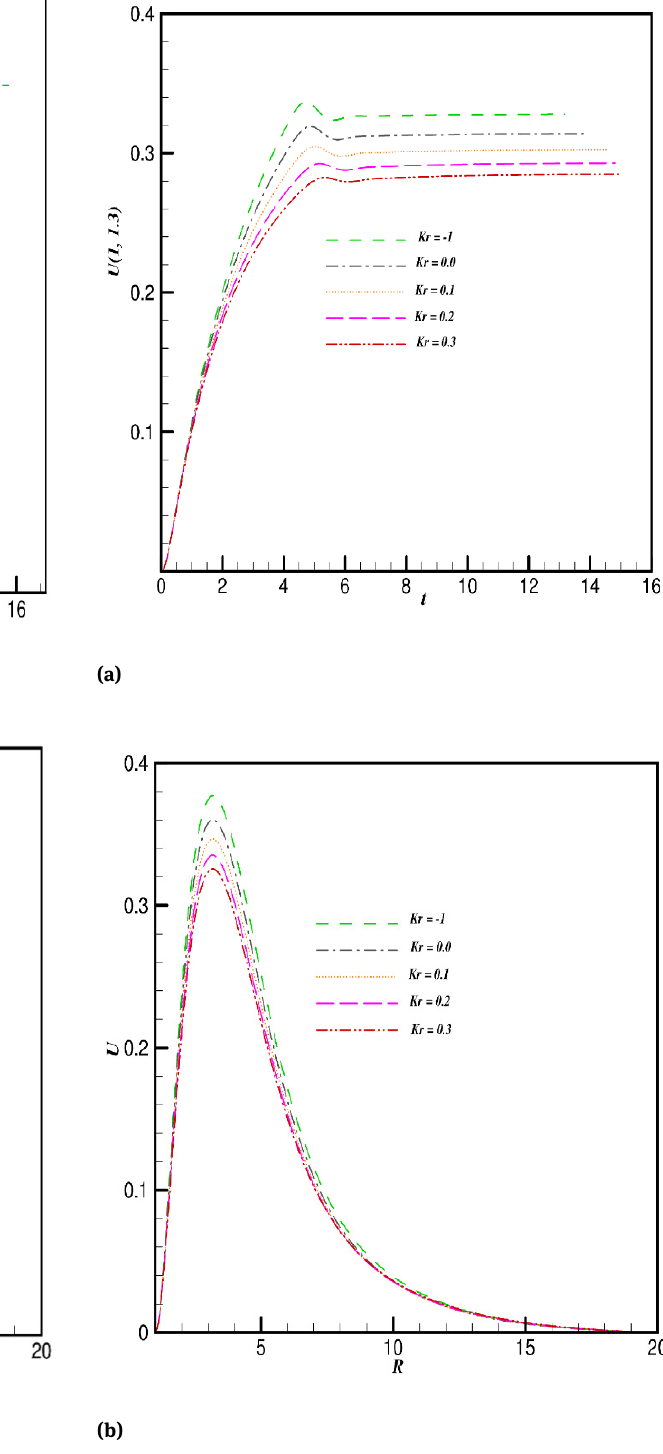
Figure 11: ( a ) Transient and ( b ) Steady state velocity profiles with fixed Sc = 0.6 , Pr = 0.7 , Bu = 1.0 , Nr = 1.0 , K 1 = 1.0 , M = 0.2 , Ec = 0.1